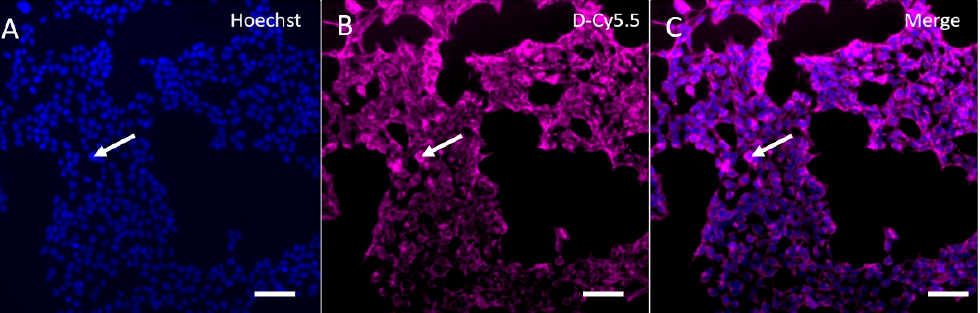
Figure 8. Uptake and retention of G4-90 / 10-Cy5.5 by HEK293 cells. Cell nuclei labeled with Hoechst 33,342 (arrow) are shown in ( A ), ( B ) shows the uptake of G4-90 / 10-Cy5.5 dendrimers by HEK293 cells (arrow), and ( C ) is the merged images of the Hoechst and G4-90 / 10-Cy5.5 staining, showing that G4-90 / 10-Cy5.5 are taken up by the HEK293 cells. Scale bar = 100 µ m.